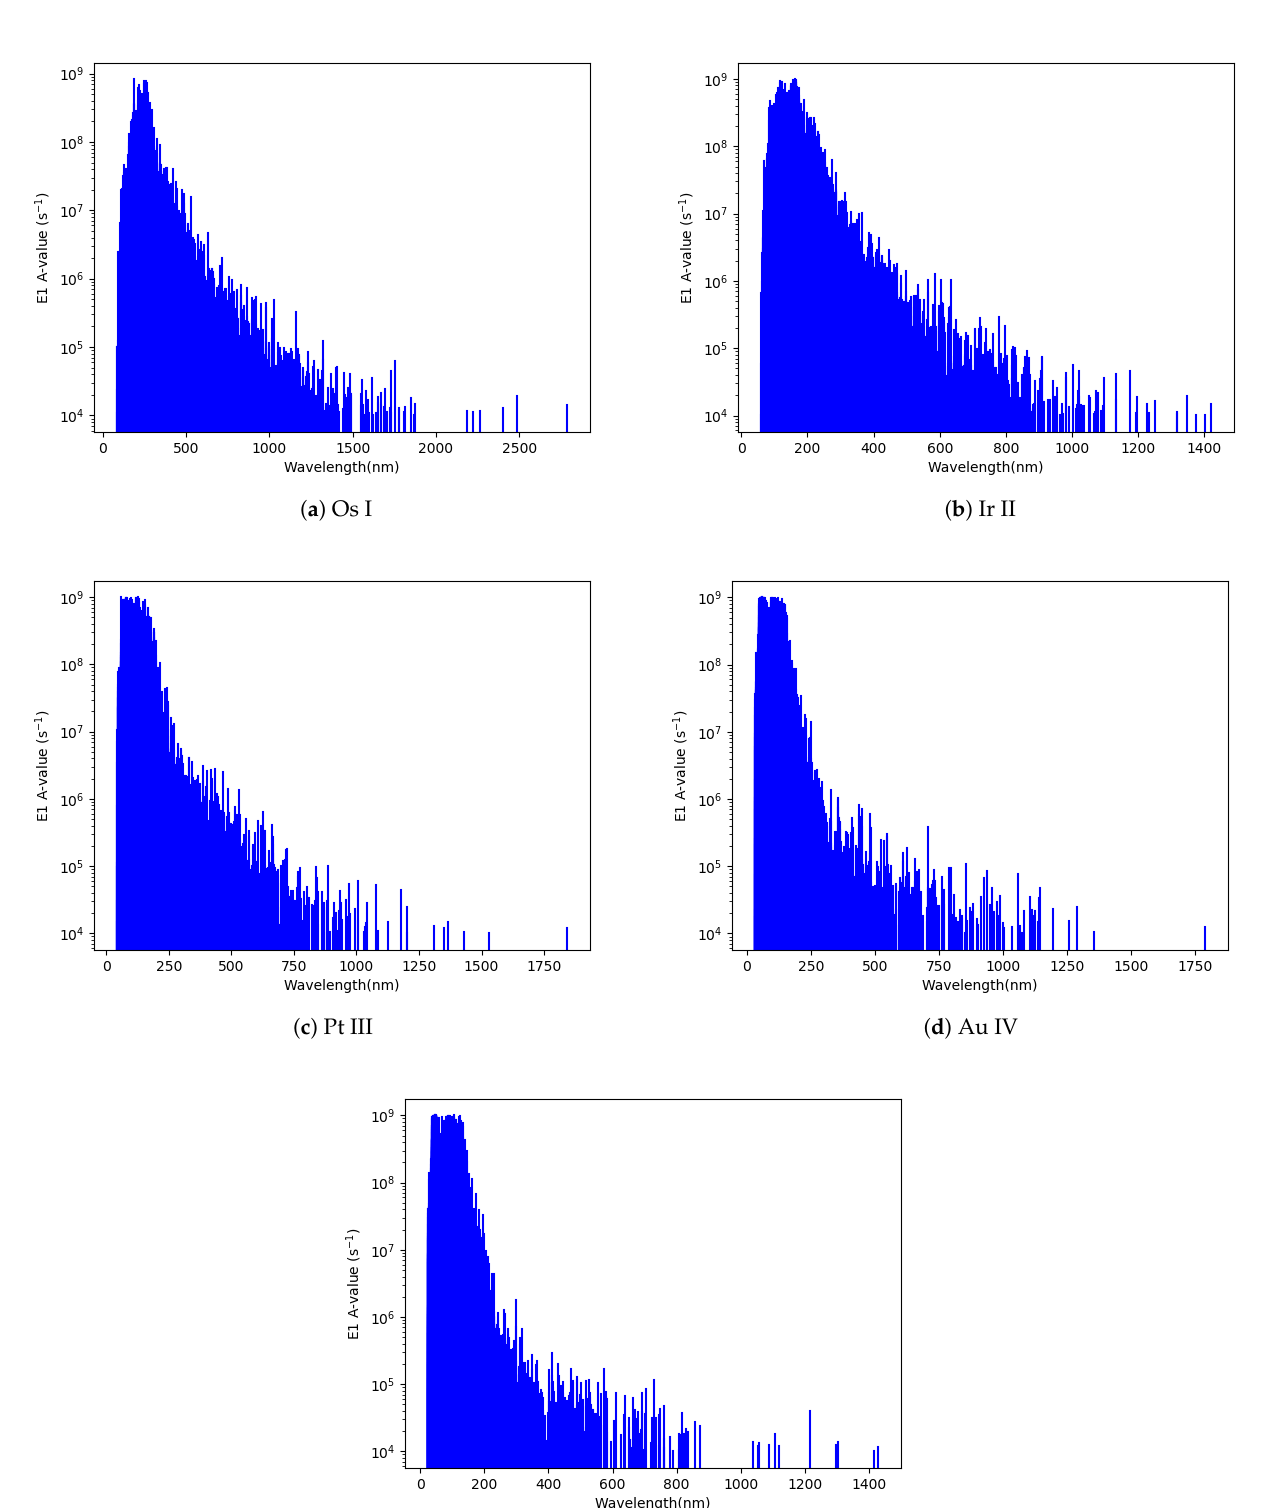
Figure 2. Transition probabilities (E1) for ( a ) Os I, ( b ) Ir II, ( c ) Pt III, ( d ) Au IV, and ( e ) Hg V obtained from GRASP2K